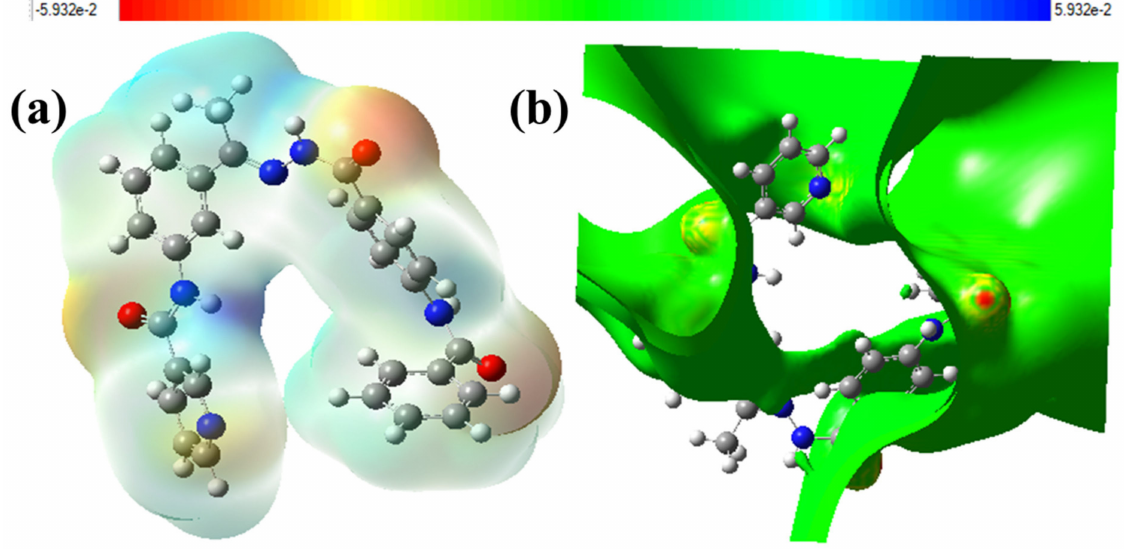
Figure 13. Total electron density, TED; ( a ) and electrostatic potential, ESP; ( b ) maps of compound 10 at the 6-311G++(d,p) basis